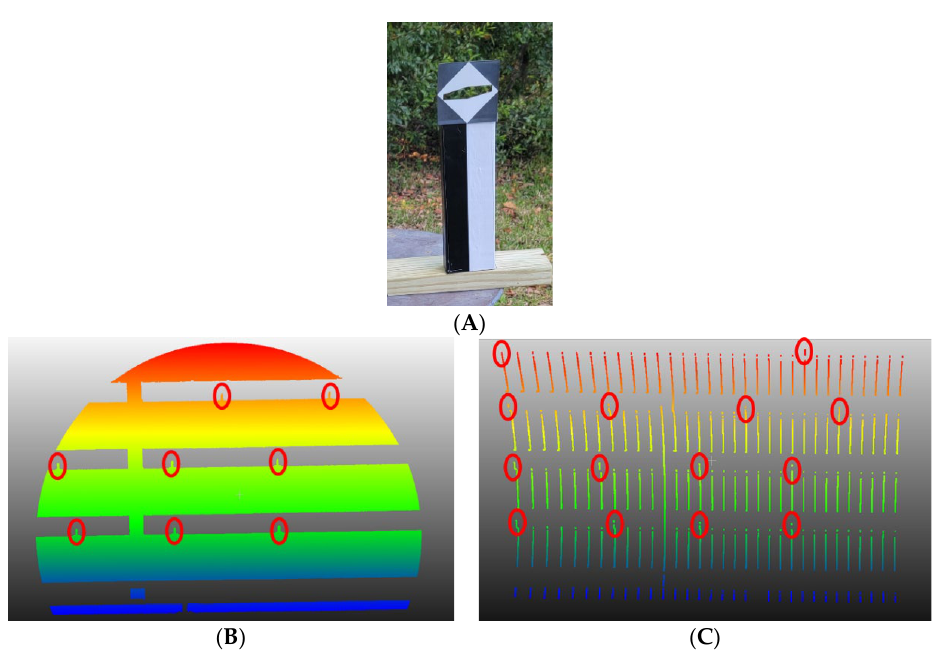
Figure 9. ( A ) Alignment targets used for absolute accuracy assessment and their locations as observed with the ( B ) Livox ® Mid–40 and ( C ) Velodyne ® HDL–32E are shown in selections from each scanner’s point clouds.